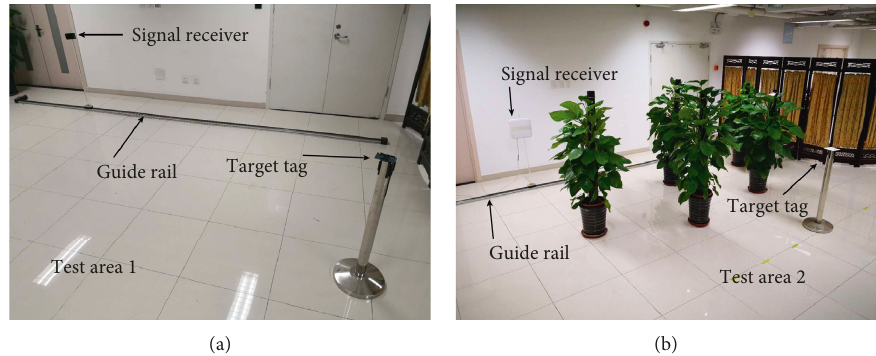
Figure 22: Large test area. (a) Laboratory space for test 1. (b) Laboratory space for test 2.